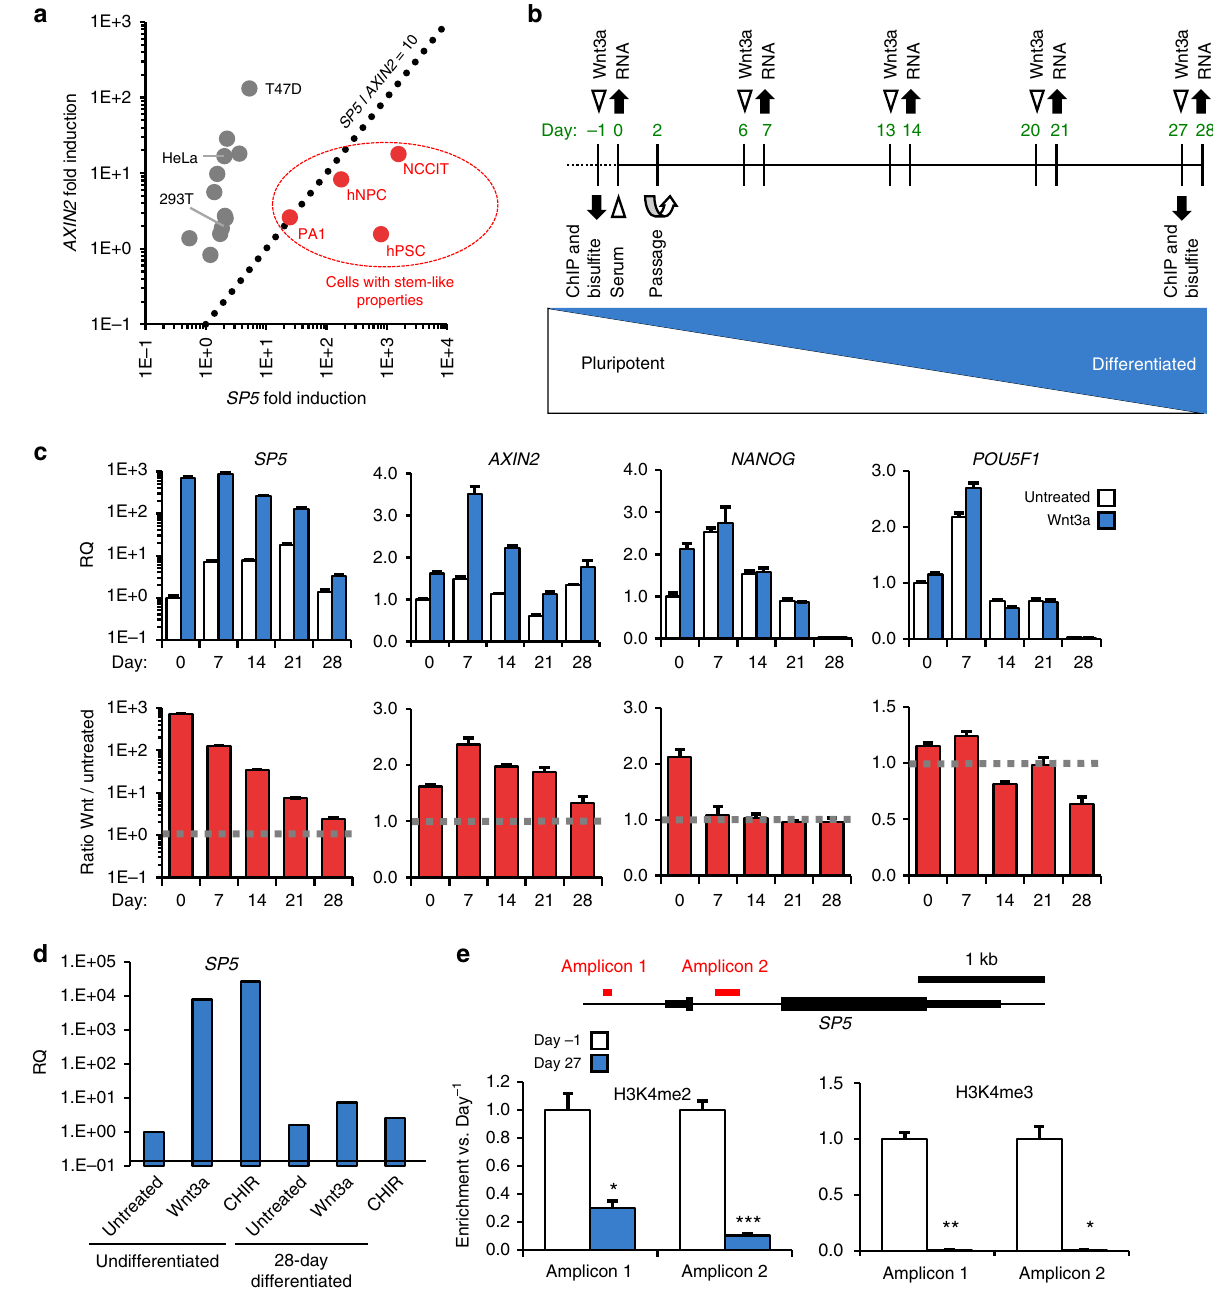
Fig. 5 Robust SP5 induction is associated with developmental potential. a SP5 and AXIN2 induction in multiple cell lines. Multiple cell lines (Supplementary Fig. 6a) were treated with Wnt3a (1 nM) for 24 h and expression of AXIN2 and SP5 was quanti fi ed by qPCR. Red dots indicate cell types with signi fi cant